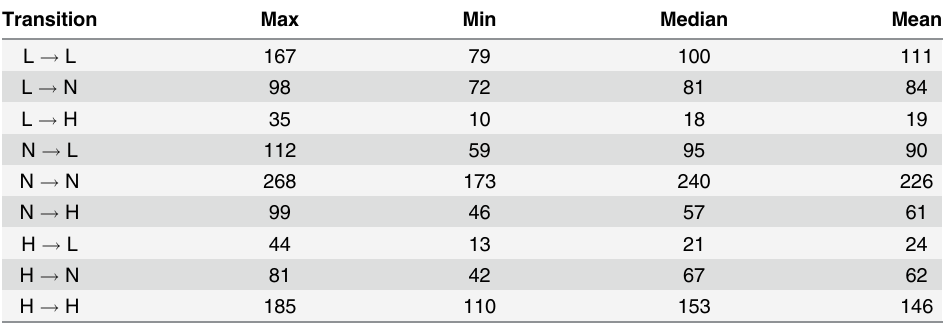
Table 2. The maximum, minimum, median and mean number of transitions between levels of states for each transition. Transition